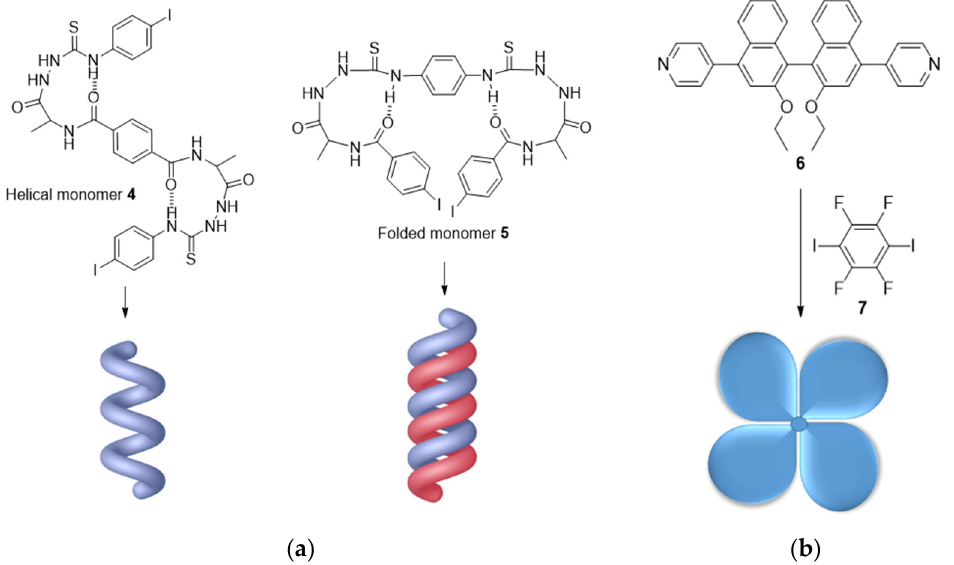
Figure 3. Representative examples of chiral amplification: ( a ) Formation of single or double helices through self-organization of 4 and 5 , respectively; ( b ) Formation of a chiral blade with increased chiroptical properties by combining 6 and 7 .